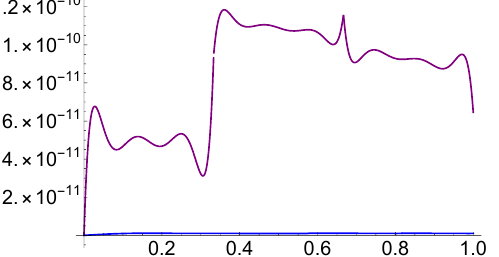
Figure 1. Absolute errors for f ( x ) , α = 1 (purple) and α = 2 (blue), for Example